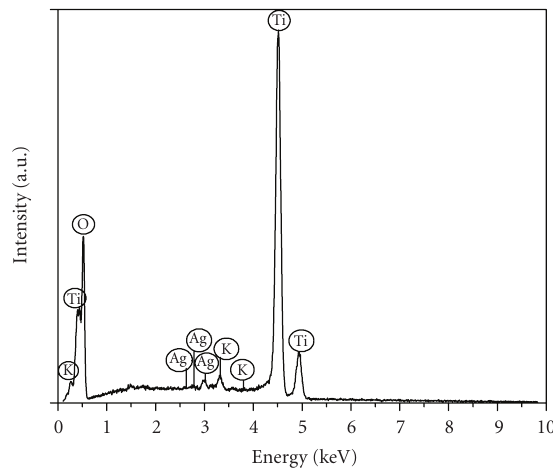
Figure 11: EDXS spectrum of 0.2 Ag-TiO 2 photocatalyst prior to the photodegradation of